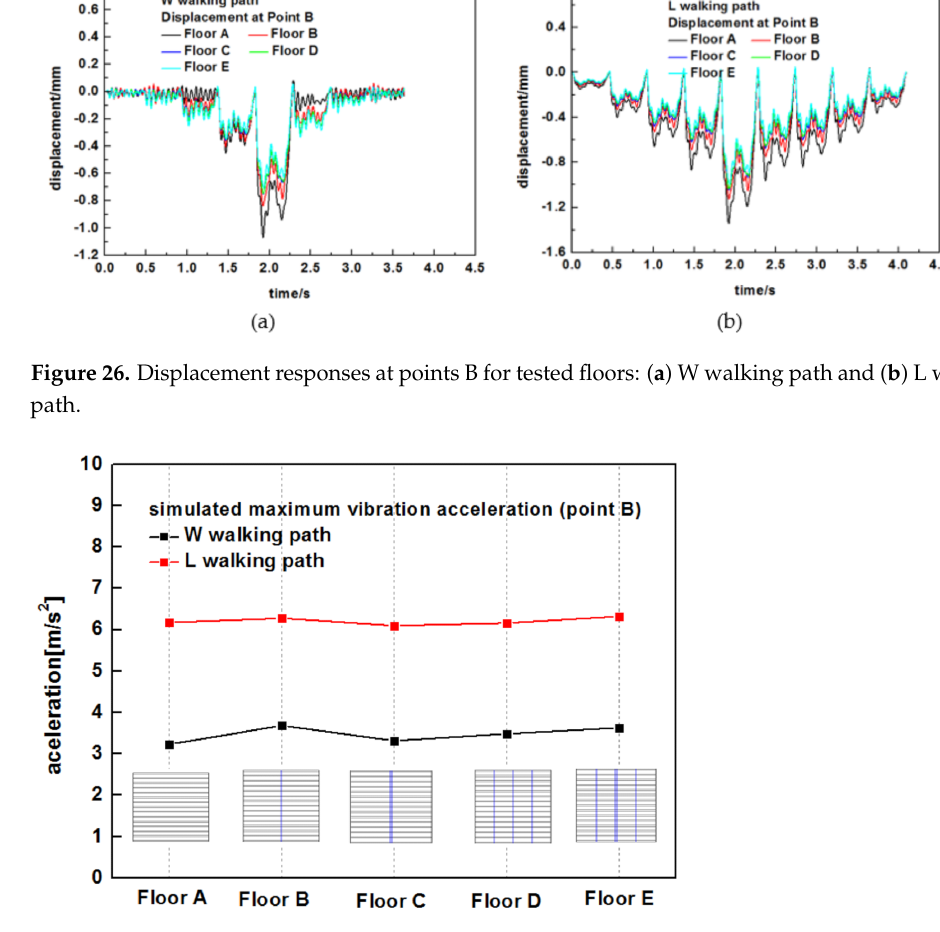
Figure 27. Simulated peak acceleration at points B for different